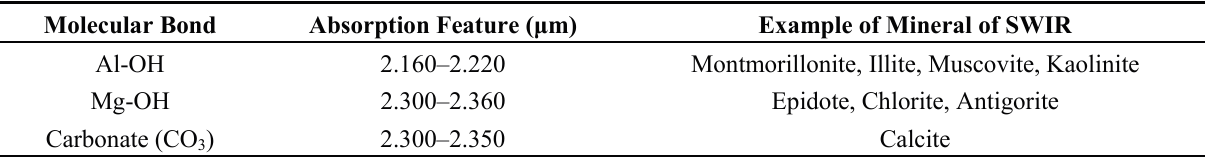
Table 2. Main molecular bonds related minerals with corresponding absorption features [51].